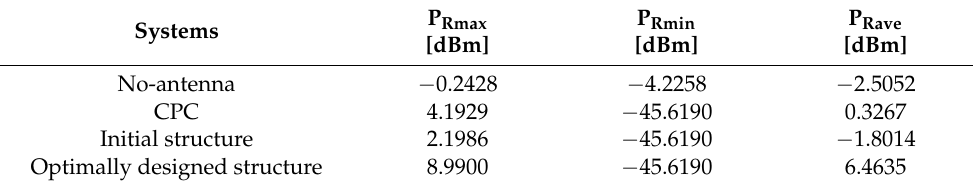
Figure 15. Diagram of the received power distribution: no antenna ( a ), the initial structure ( b ), the optimally designed structure ( c ). Table 10. Receiving power comparison of different antenna structures.